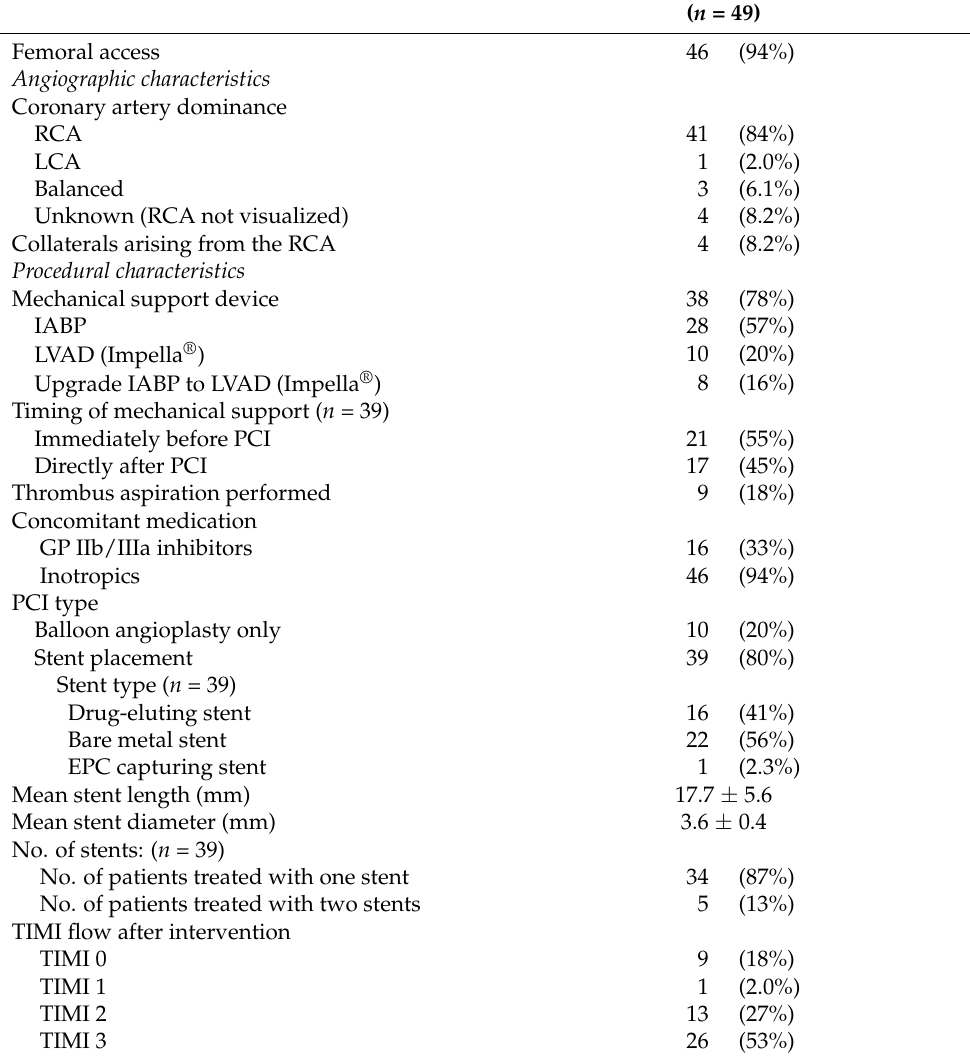
Table 2. Angiographic and Procedural